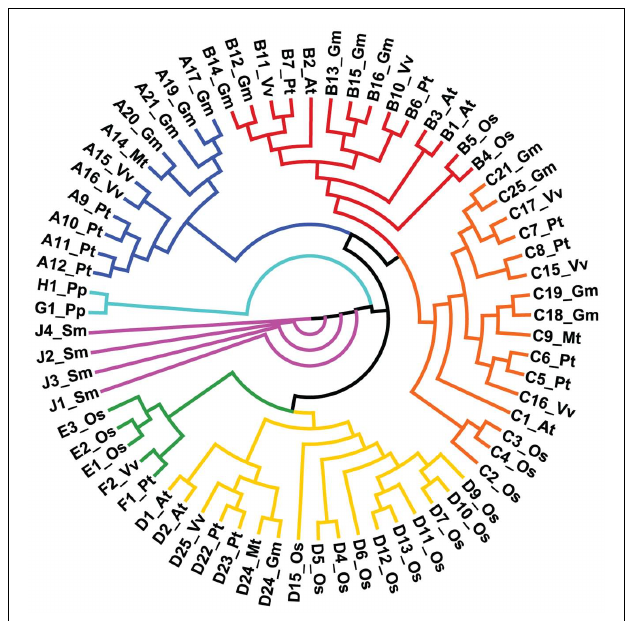
FIGURE 3 | Phylogeny of the CYP94 family of cytochrome P450s in the land plants. A total of 70 deduced full-length amino acid sequences were aligned by Clustal X and displayed as a circular cladogram using Phylip 3.68 and DENDROSCOPE v3.0.13beta (Huson et al., 2007). Abbreviations and number of sequences: Arabidopsis thaliana (At: 6), Oryza sativa (Os: 18), Glycine max (Gm: 14), Medicago truncatula (Mt: 4), Vitis vinifera (Vv: 9), Populus trichocarpa (Pt: 13), Physcomitrella patens (Pp: 2), Selaginella moellendorffii (Sm: